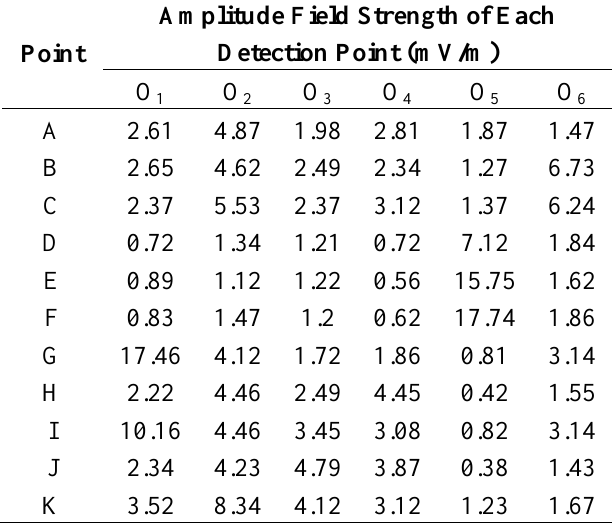
Table 5. Amplitude field strength of each detection point. Point